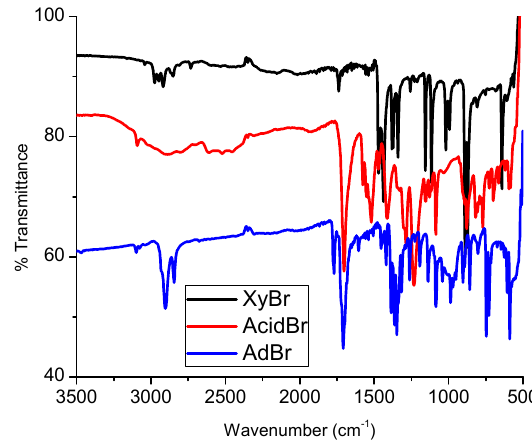
Figure 3. FTIR spectra of AdBr and its precursors.